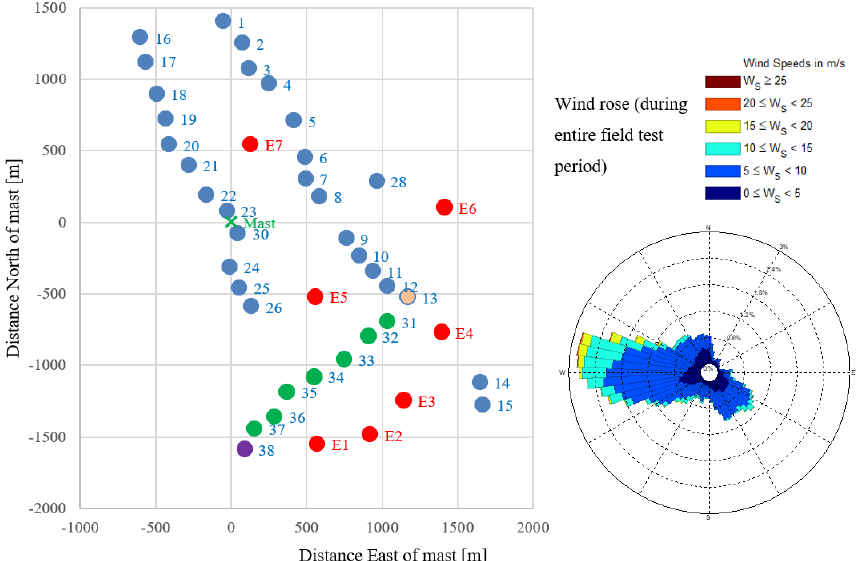
Figure 1. Site layout. Induction control field test involves turbines 13 and 31–38, with winds from the south-west. The setpoint optimisation maximises the total power from these nine turbines. Controlled turbines are in dark green. Turbine 38 is used as the reference from which wind conditions are calculated. Turbine 13 is affected but not controlled, as its wake does not affect other